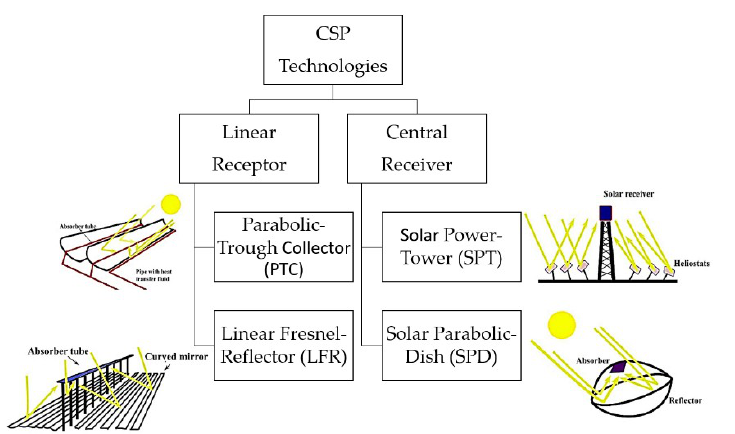
Figure 1. Classification of existing concentrated solar power (CSP) technologies. Source of the images [17].